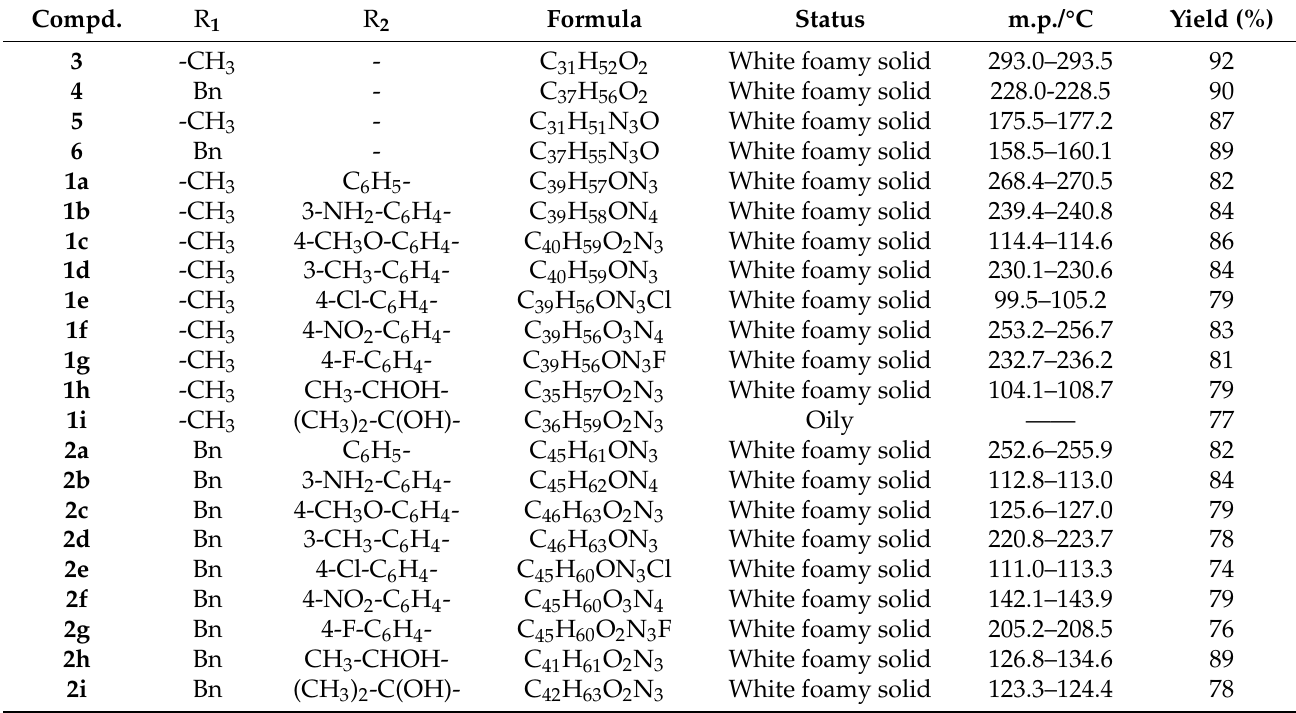
Table 1. Physical data of intermediate products and target